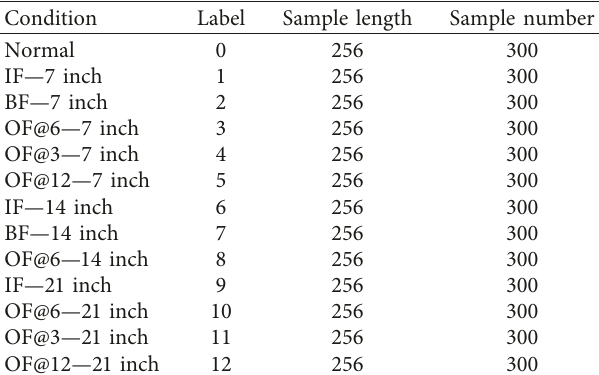
Table 1: Experiment samples.